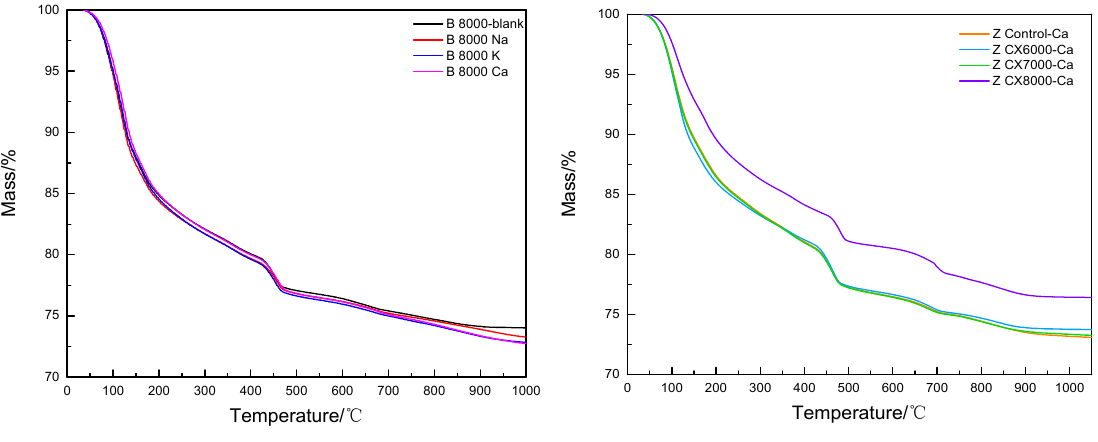
( e ) 90 d TG curves of ultrafine cement with different curing temperatures.